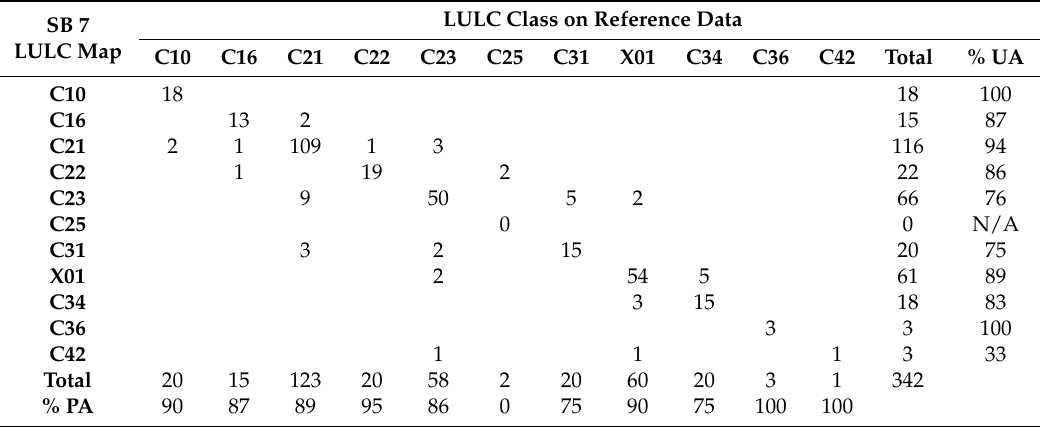
Table 4. SB 7 LULC map error matrix for scheme with only one deciduous forest class instead of three (PA = Producer Agreement and UA = User Agreement). This matrix is identical to the one shown in Table 3 except for the deciduous forests being grouped as a singular class. See Table 3 for descriptions of the non-merged class numbers in the table